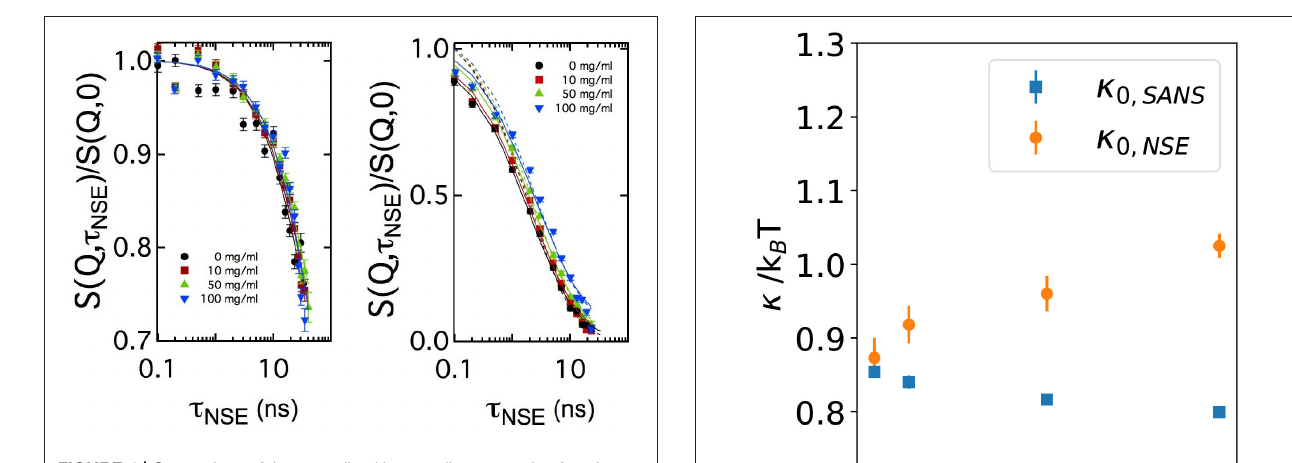
FIGURE 4 | Comparison of the normalized intermediate scattering functions S ( Q , τ NSE ) / S ( Q ,0) measured at Q 0.05Å -1 and Q 0.18Å -1 for all enzyme = = concentrations in semi-logarithmic representation. In the low Q-range, corresponding to length scales close to 2 π/ Q max , no significant difference in the decay rates is visible while at length scales much smaller than 2 π/ Q max the decay of the intermediate scattering function slows down with increasing FIGURE 5 | Bending rigidity constant κ 0 obtained from fitting Equation (5) to enzyme concentration. Solid lines are fits according to Equation (5). Additional the normalized intermediate scattering functions shown in Figure 1 for four dashed lines in the right image show fitting results with a fixed amplitude of samples with different lipase concentrations. Results from neutron spin echo S ( Q , τ NSE ) / S ( Q ,0) 1, while the solid line uses this amplitude as additional = (NSE) measurements are compared with the resulting values from analyzing free fitting parameter. the small angle neutron scattering (SANS)